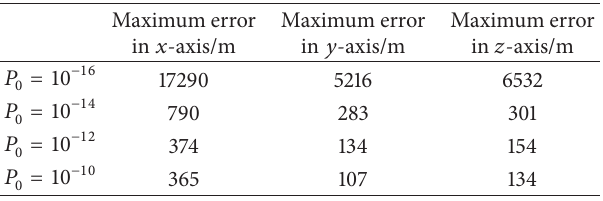
Table 5: The maximum AOD error of 𝐿 2 using SR-EKF